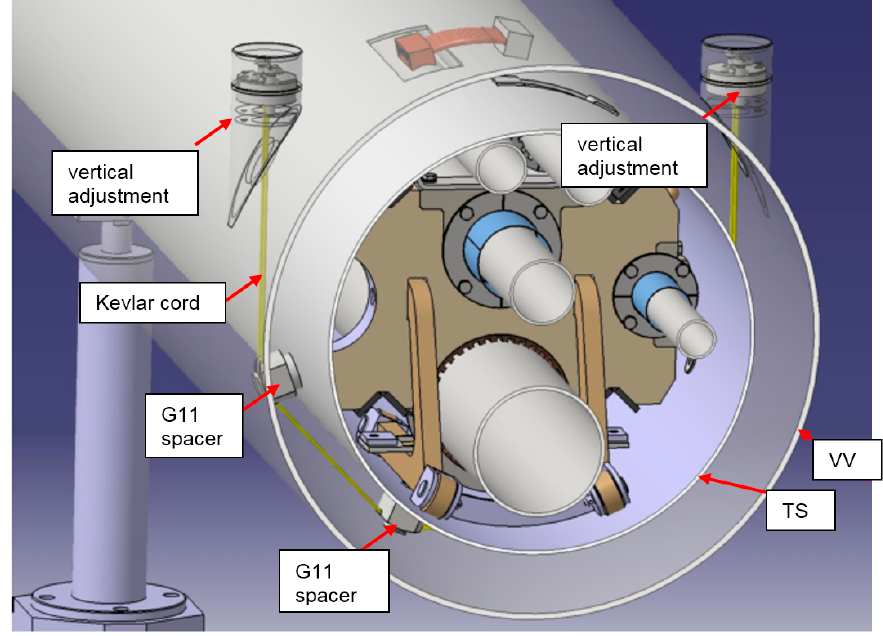
Figure 8. Suspension of the thermal shield (aramid fiber cable version) with interior details.